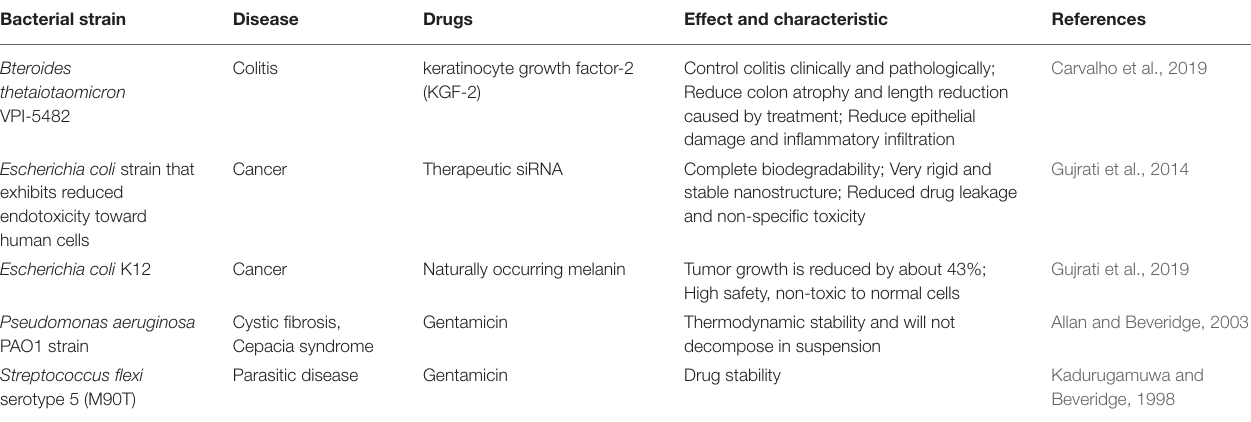
TABLE 3 | Engineering OMVs delivering drugs and corresponding efficacy of